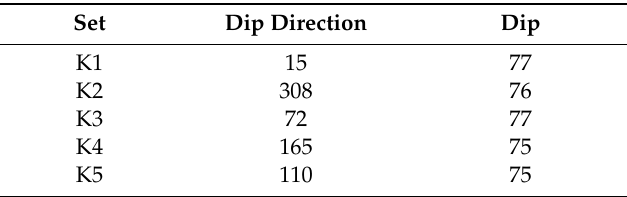
Table 1. Average attitude of the discontinuity sets at Santa Caterina rock cli ff , identified through geo-structural analysis on point cloud.